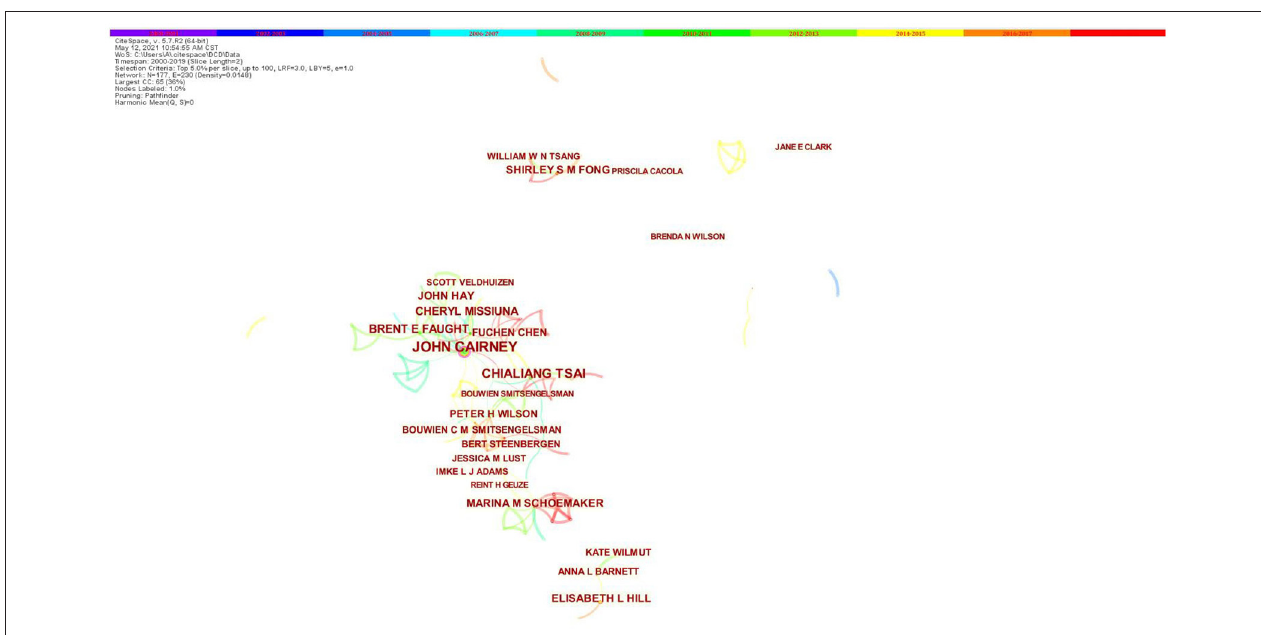
FIGURE 4 | Co-authorship network map in research of children with DCD, 2000–2019. The bigger the circle, the more original articles the author published. The shorter and thicker the connection line, the closer relationship between authors.